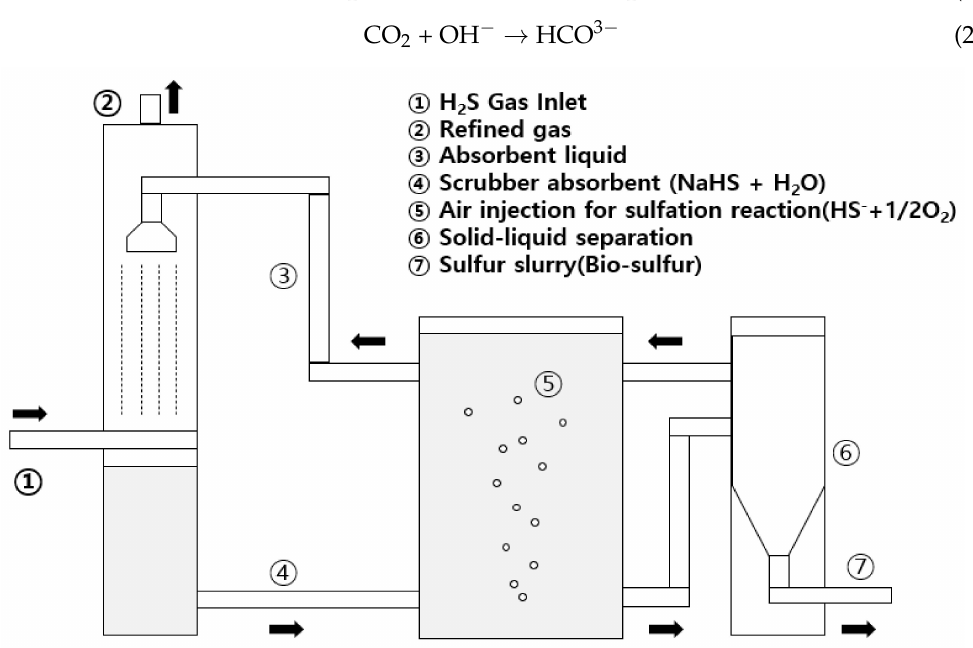
Figure 2. Process diagram of the scheme for H 2 S removal from landfill gas. This system removes the H 2 S contained in Thiopaq’s LFG. When the landfill gas flows in, the refined gas is discharged, and H 2 S reacts with OH − and is converted to HS − liquid . The converted HS − is converted through the oxidation reaction of microorganisms in the